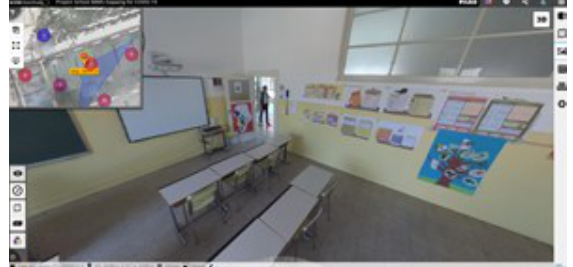
accessible also by not CAD or LiDAR experts.